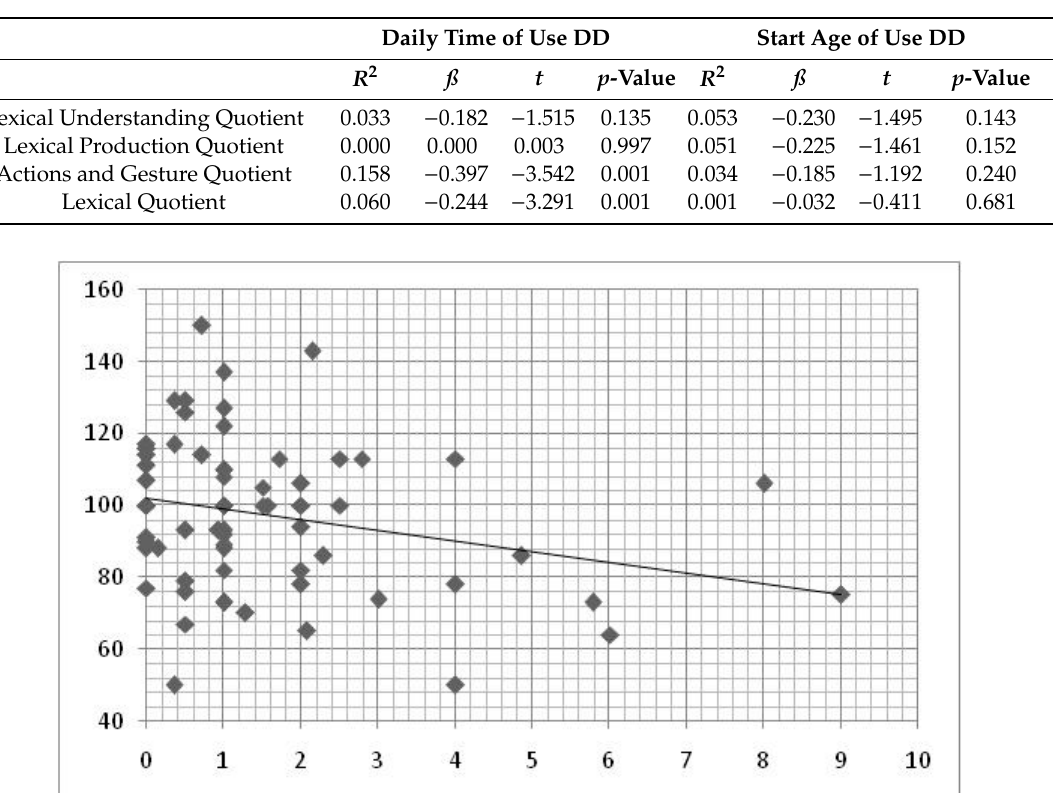
Figure 1. Linear regression between time of DD use by the children and Actions and Gesture Quotient. x axis = hours/day of DD use; y axis = Actions and Gestures Quotient scores.